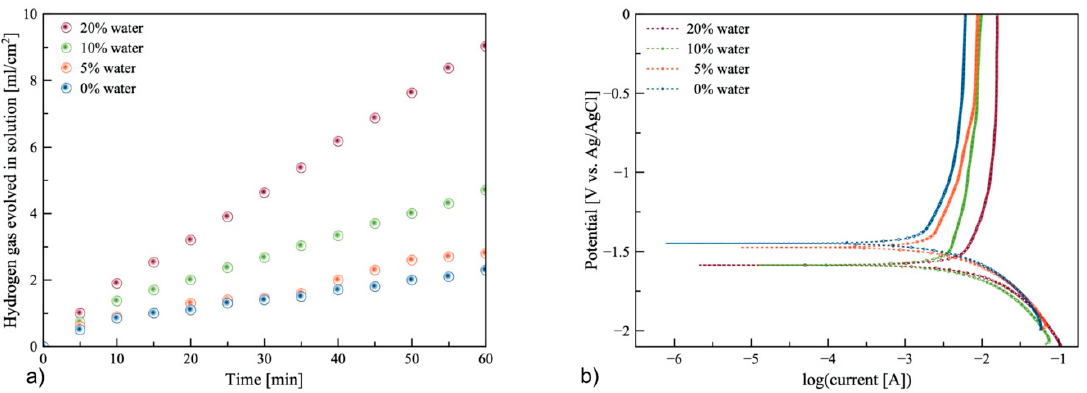
Figure 2. ( a ) Hydrogen gas evolved from an Al sample in methanol solutions containing 3M potassium hydroxide (KOH) with different ratios of water (0%, 5%, 10%, and 20% (v/v)). ( b ) Tafel polarization of an Al electrode in methanol solutions containing 3M KOH with different ratios of water (0%,5%, 10%, and 20% (v/v)).